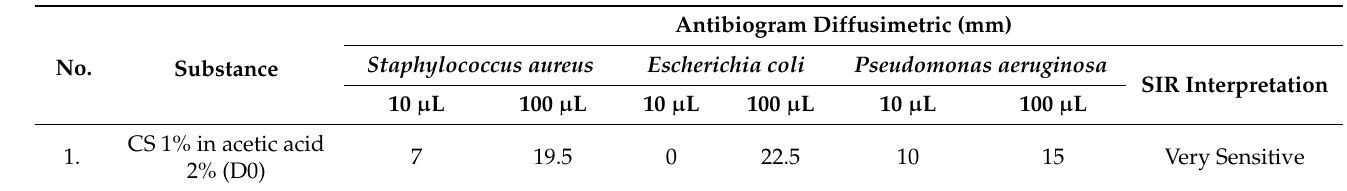
Table 2. Testing of substances by the adapted diffusimetric antibiogram